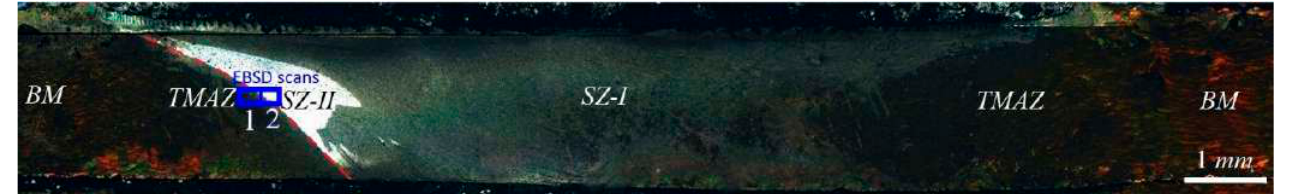
Figure 7. Cross-sectional macrostructure of 2-pass friction stir processed sample. The blue rectangles indicate areas 1 and 2 of EBSD scans. The details of the FSP reference frame are the same as Figure 2. The interface between TMAZ and SZ is depicted by a red-dashed line.